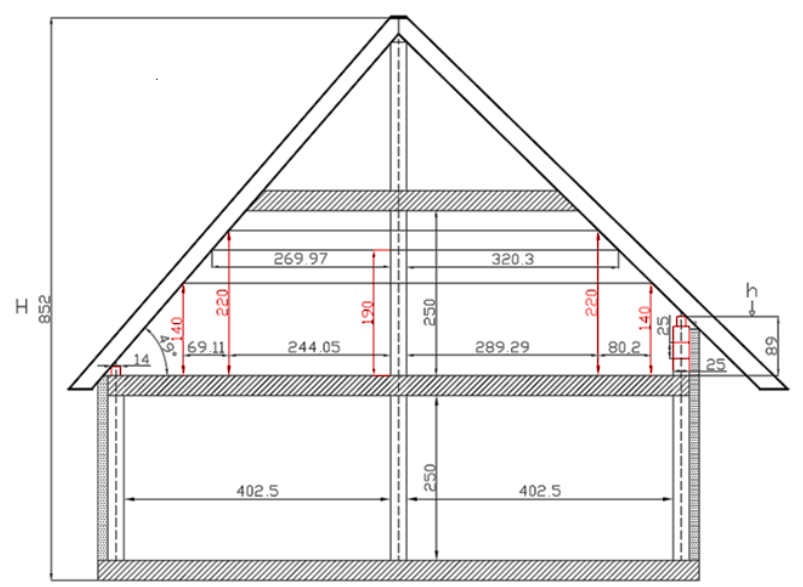
Figure 1. Sketch of the building used to model the relationship between the usable area and the building’s and the knee wall’s heights. H —height of the building, and h —height of the knee wall. The red values marked on the sketch are the verging heights for three used norms described in Section 2.1: 140, 190, and 220